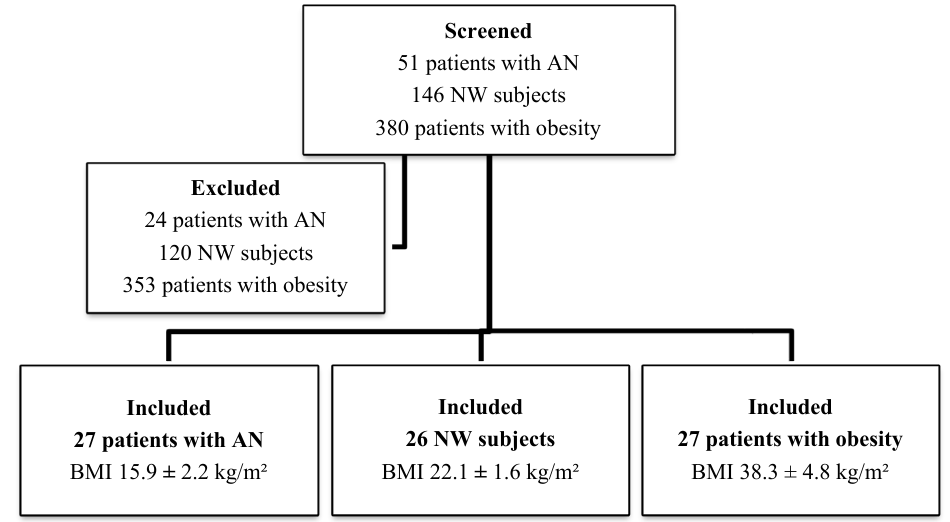
Figure 1. Patient selection flowchart. AN: anorexia nervosa; NW: normal weight; BMI: body mass index.